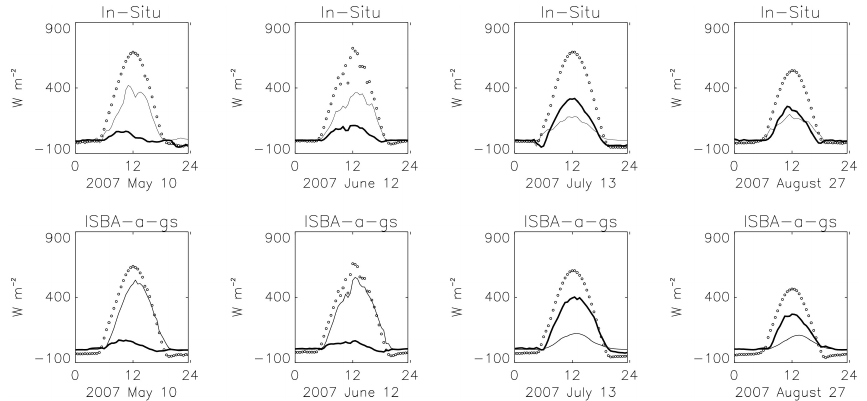
Fig. 5. Observed (top) and simulated (bottom) energy fluxes for 4 daily cycles in May, June, July and August 2007: Rn (dots), H (thick), LE (fine line).